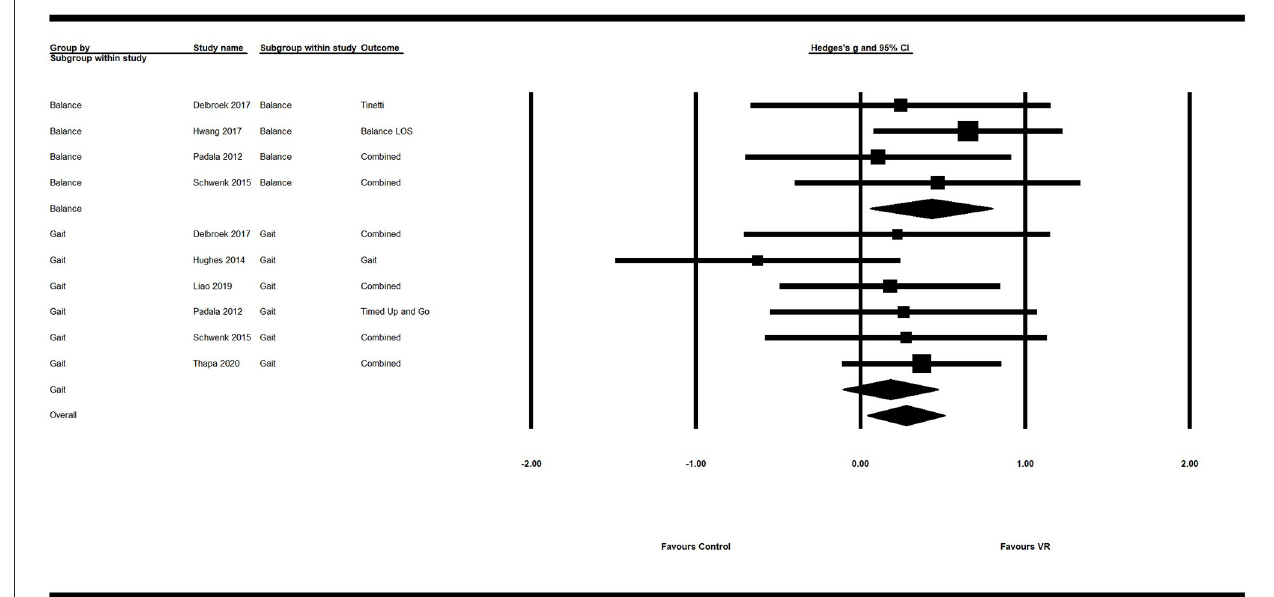
FIGURE 3 | Forest plot for the efficacy of VR intervention on motor functions compared with the control group.